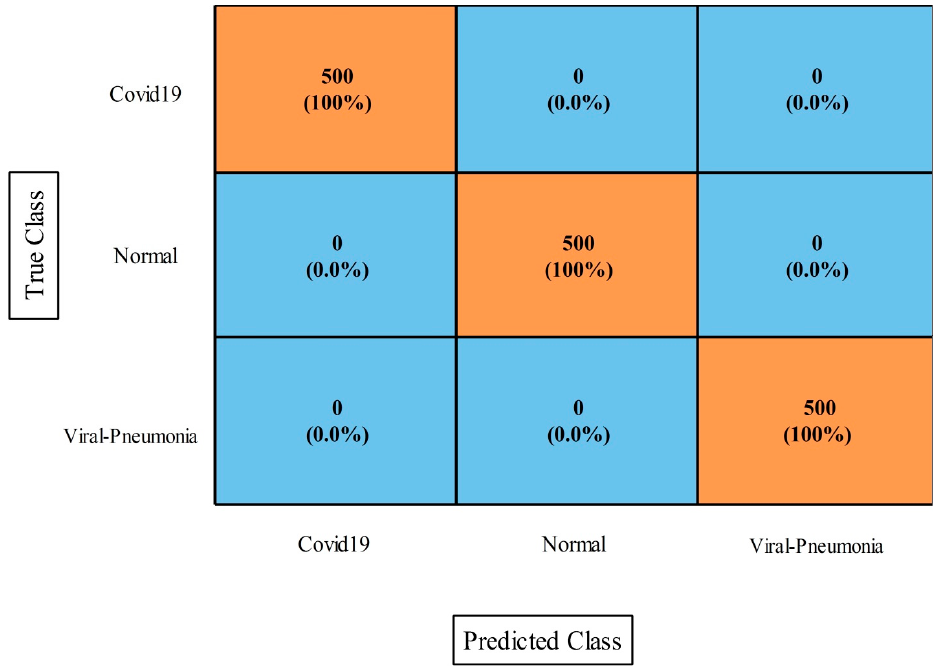
Figure 15. Confusion matrix of tri-layered neural network classifier on COVID-19 Detection dataset.